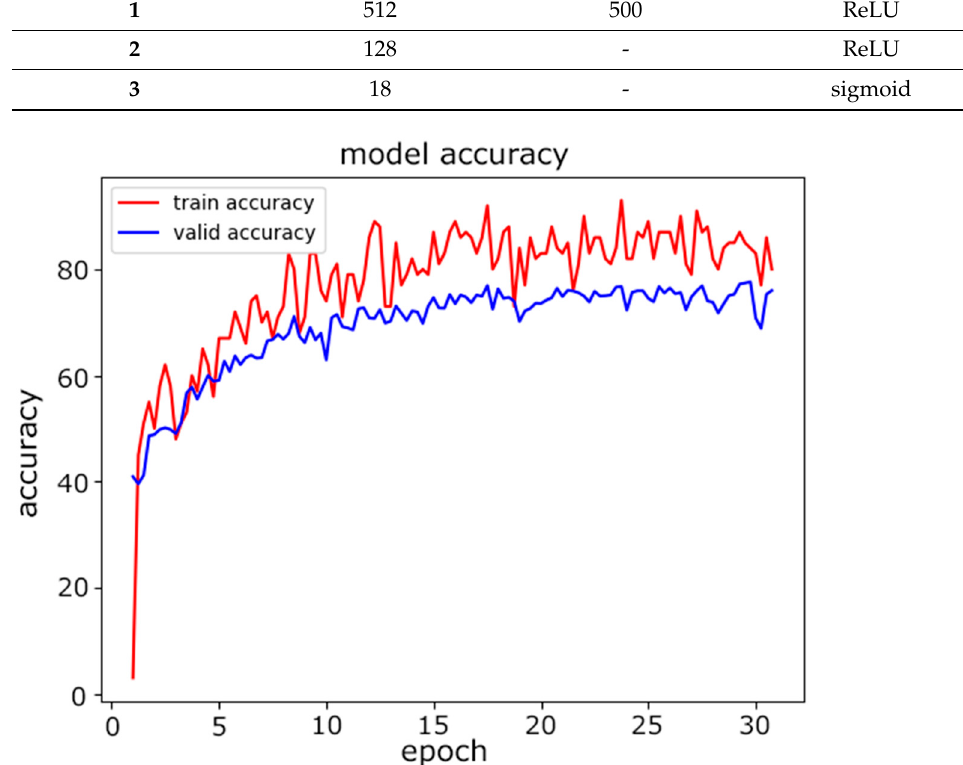
Figure 5. MLP model accuracy.